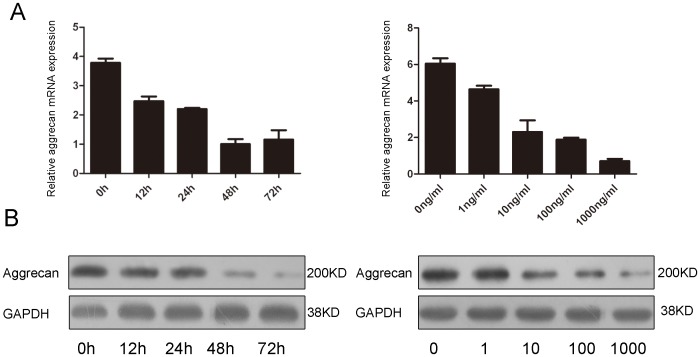
Leptin inhibited aggrecan expression.(A) Leptin (10 ng/ml) significantly inhibited aggrecan transcription in a time-dependent manner, with a maximal response both at 48 h. Dose-dependent studies demonstrated a maximal response to leptin (1–1000 ng/ml) was at the concentration of 1000 ng/ml at the 48 h time point. (B) The effect of leptin on aggrecan protein expression was detected with western blotting ananlysis using GAPDH as an internal control. Error bars represent standard deviration.